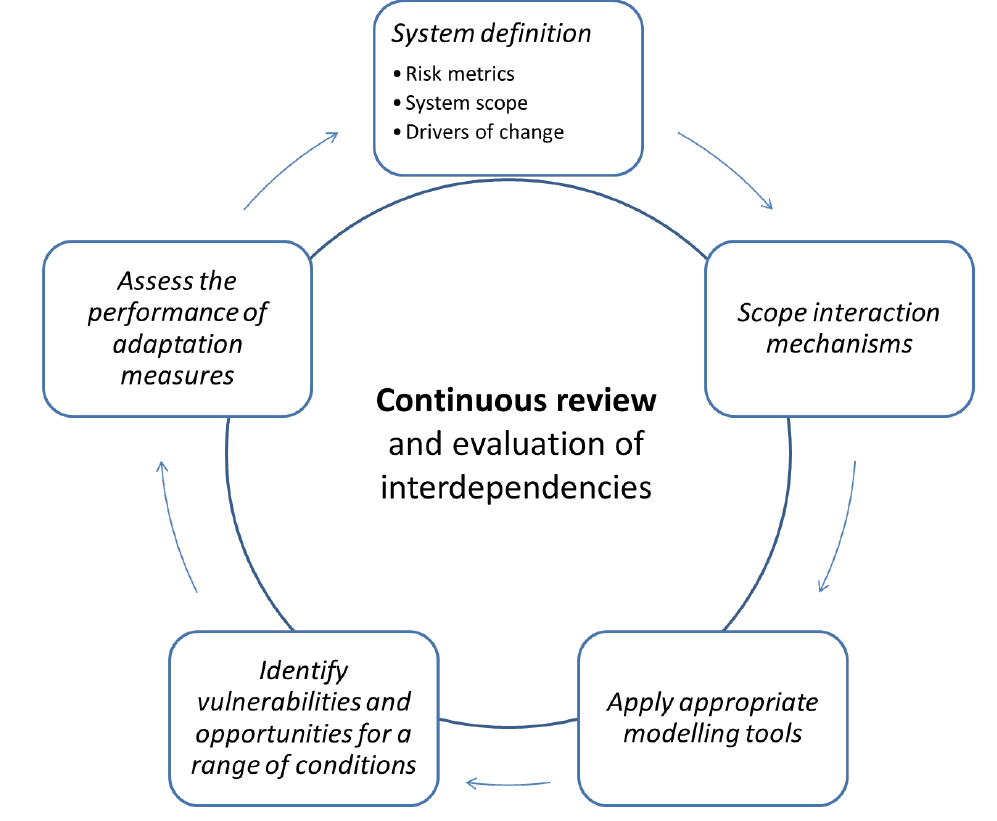
Figure 7. Framework for analysis and consideration of interdependencies in climate risk